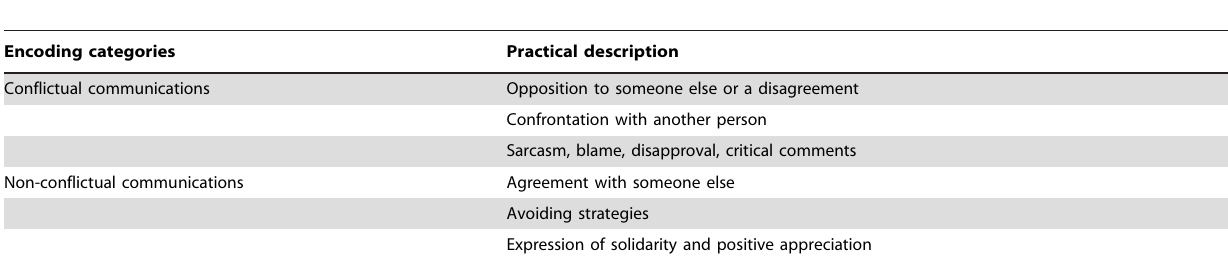
Table 1. Operational definitions of the encoding categories for conflictual and non-conflictual verbal communication between family